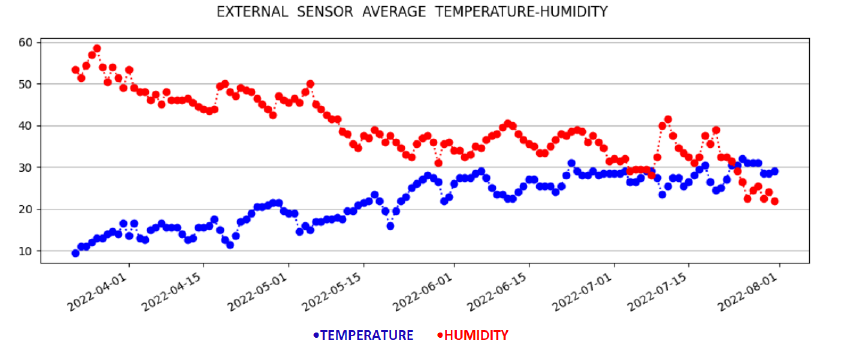
Figure 5. Temperature and humiditytime plots in a target